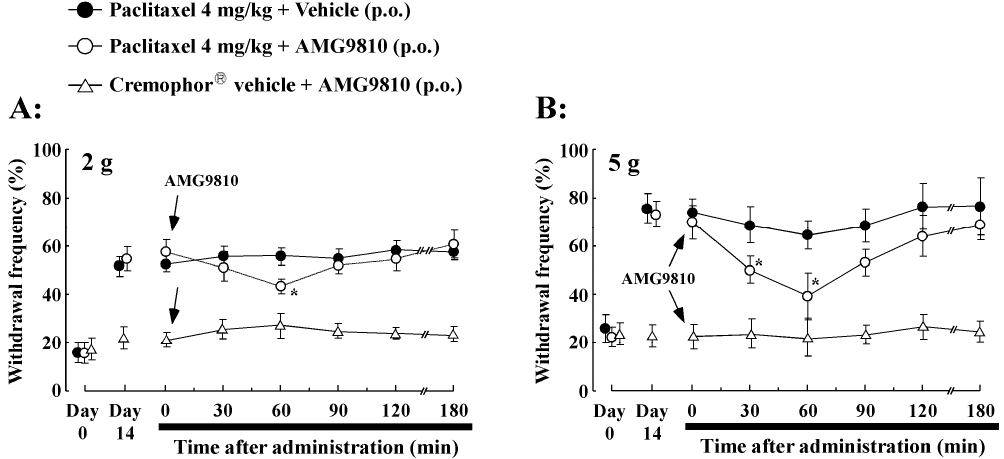
Figure 3. Effect of oral administration of a TRPV1 antagonist (AMG9810, 30 mg/kg) on paclitaxel-induced mechanical allodynia/hyperalgesia. ( A ) von Frey filaments (2 g) and ( B ) von Frey filaments (5 g) was used to measure mechanical allodynia/hyperalgesia (paw withdrawal frequency) induced by 4 mg/kg of paclitaxel treatment in rats. Oral administration of AMG9810 was conducted at day 14. Paclitaxel-induced mechanical allodynia/hyperalgesia was significantly inhibited by AMG9810. Data are the mean ± SEM of n = 8–10 rats. * p < 0.05 from before AMG9810 administration.